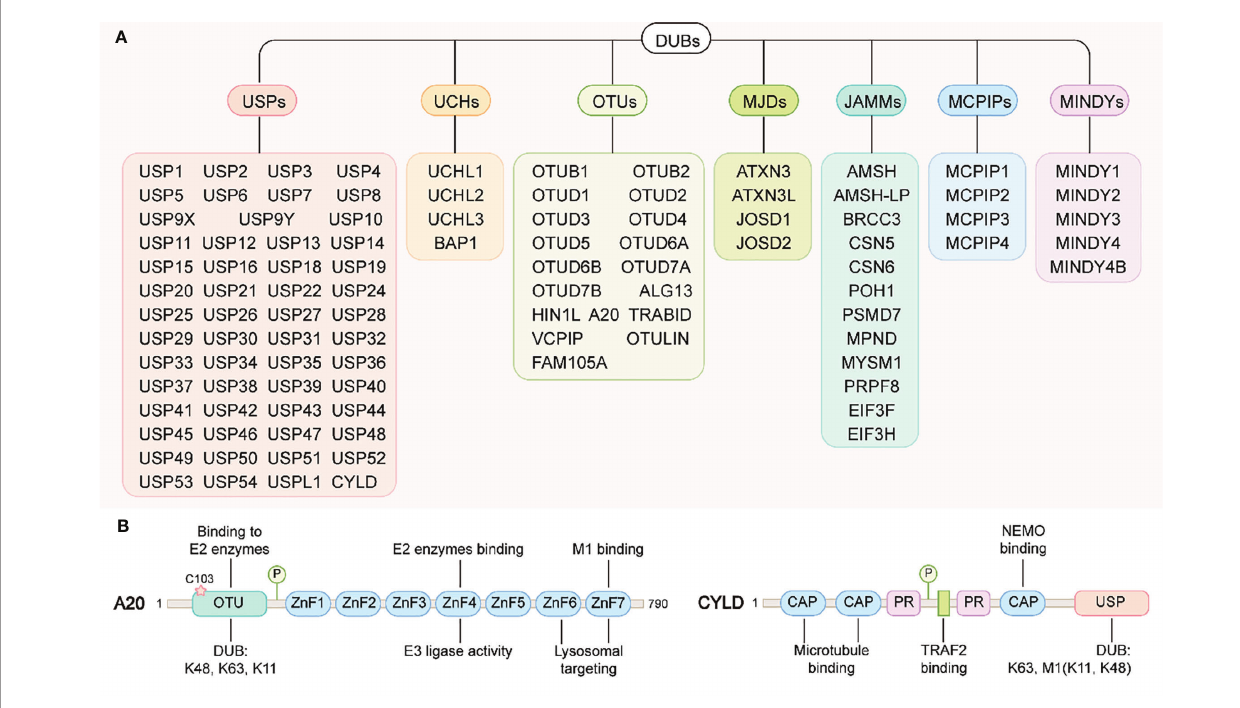
FIGURE 4 | DUBs family and the structural domains of A20 and CYLD. (A) DUBs family. DUBs can be divided into seven types: ubiquitin c-terminal hydrolases (UCHs), ubiquitin-speci fi c proteases (USPs), ovarian tumor-related proteases (OTUs), Machado-Joseph disease protein domain proteases (MJDs), Jab1/MPN domain-associated metalloisopeptidase(JAMMs), monocyte chemotactic protein-induced proteins (MCPIPs) and motif interacting with ub-containing novel DUB family(MINDYs). (B) A20 structural domains(left): A20 contains an N-terminal OTU domain responsible for the DUB activity of A20. The catalytic cysteine residue Cys103 is also important for binding to the E2 enzymes. A20 contains seven zinc fi nger domains in its C-terminus. ZnF4 confers A20 E3 ligase activity, where as ZnF7 have been essential for A20 binding to M1-linked ubiquitin chain. In addition, ZnF6 and ZnF7 are required for A20 targeting to lysosomes. CYLD structural domains(right): the N-terminal of CYLD contains three CAP structural domains and two proline-rich (PR) motifs, of which the fi rst two CAP domains are responsible for binding to microtubules and the third interacts with NEMO (also called IKK g ). Between the two PR motifs there is one binding site to TRAF2. The C-terminus of CYLD contains a USP structural domain responsible for its DUB